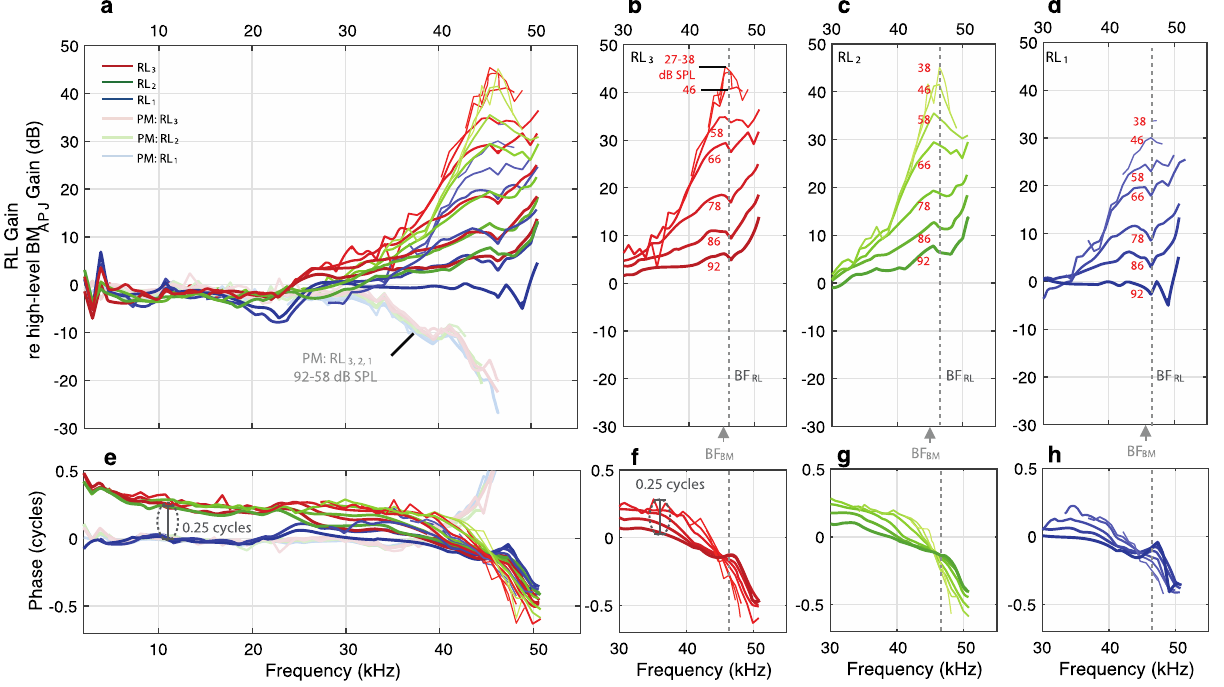
Figure 4. The in vivo and PM RL gains, normalized by the BM APJ gain (measured at a high stimulus level), in order to remove the effects of the cochlear traveling wave, for specimen G637. ( a ) Direct comparisons of the in vivo and PM RL 3, 2, 1 normalized gains (in dB). ( b–d ) In vivo normalized gains in the near-BF region for RL 3 , RL 2 , and RL 1 , respectively. ( e–h ) The phase responses corresponding to panels ( a–d ), respectively. Note that the baseline high-level BM APJ gain used for normalization was calculated as the average of ten measurements made at 92 dB SPL. All frequency axes in this figure are on a linear